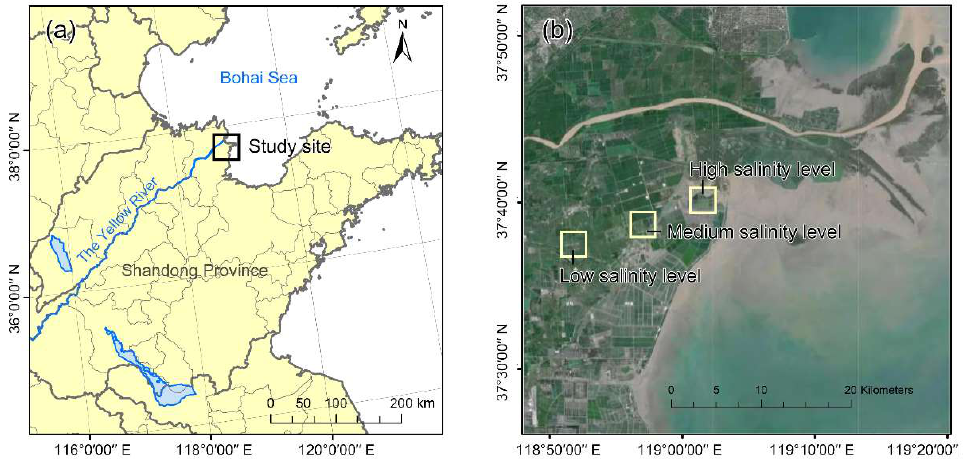
Figure 1. Location of the study area ( a ) and overview of the experimental site ( b